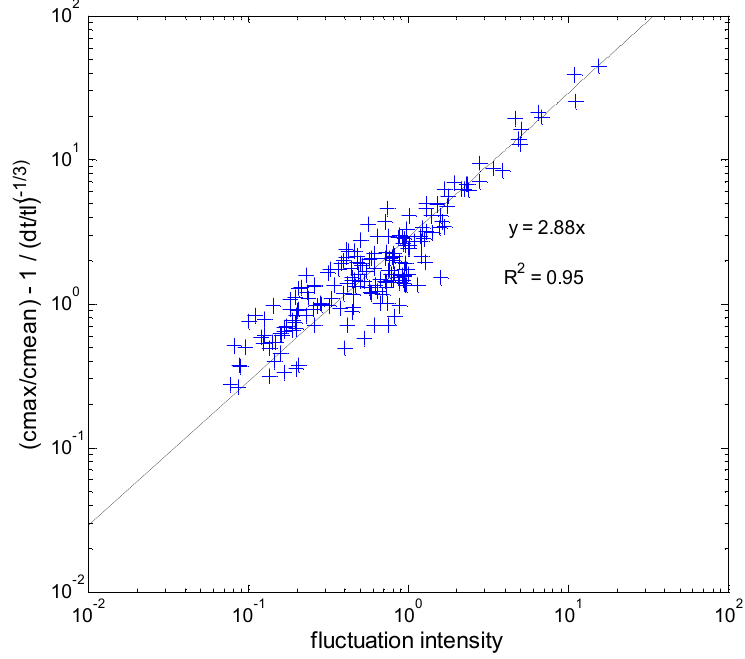
Figure 2. Correlation between the quantity Equation (4) and the fluctuation intensity ( I ). The data follow a linear relationship with a slope of 2.88 and a correlation coefficient R 2 =